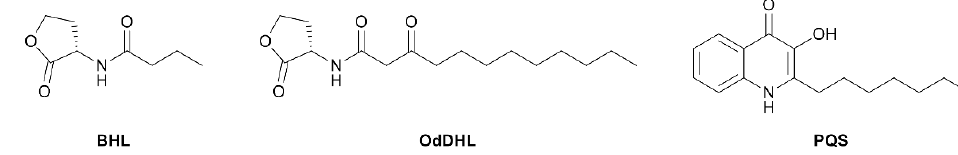
Figure 2. Chemical structure of auto-inducers BHL, OdDHL and